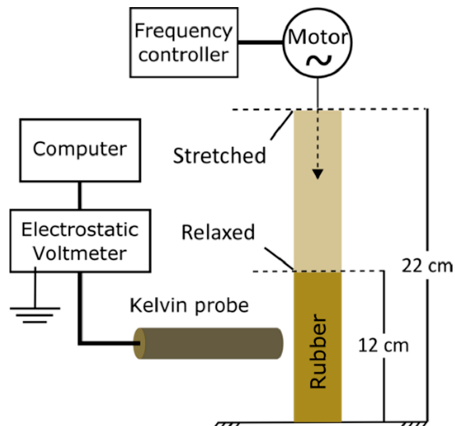
Figure 1. Schematic description of the apparatus used to measure electric potential on periodically stretched natural rubber.